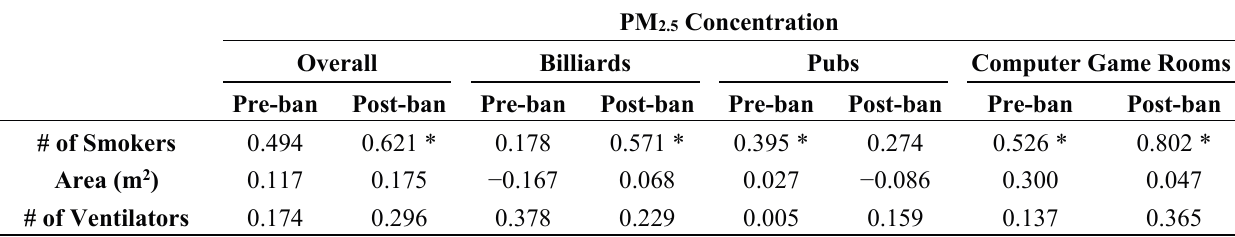
Figure 1. Comparison of distributions of PM 2.5 concentrations measured between pre-ban (2013) and post-ban period (2014) ( p -values from the Wilcoxon signed-rank test). Table 2. Spearman correlation coefficients between indoor PM 2.5 concentration and other SHS-related variables, according to sampling period and